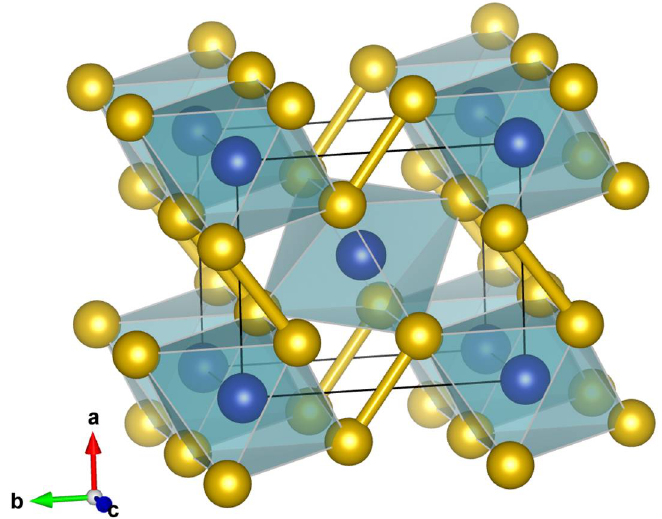
Figure 1. Representation of the crystal structure of marcasite-type FeSe 2 generated with VESTA [11]. Iron atoms (blue) are coordinated to 6 selenium atoms (yellow) defining a tetragonally compressed octahedron. Selenium dumbbells lie in the ab plane and connect the chains of octahedra running parallel to the c -axis.